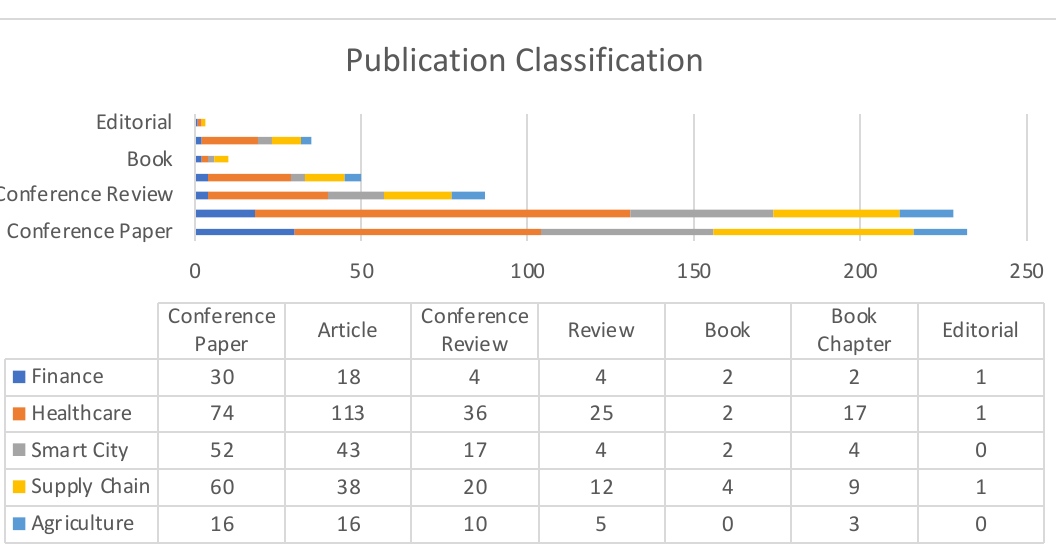
Figure 2. Publication count comparison among application areas.